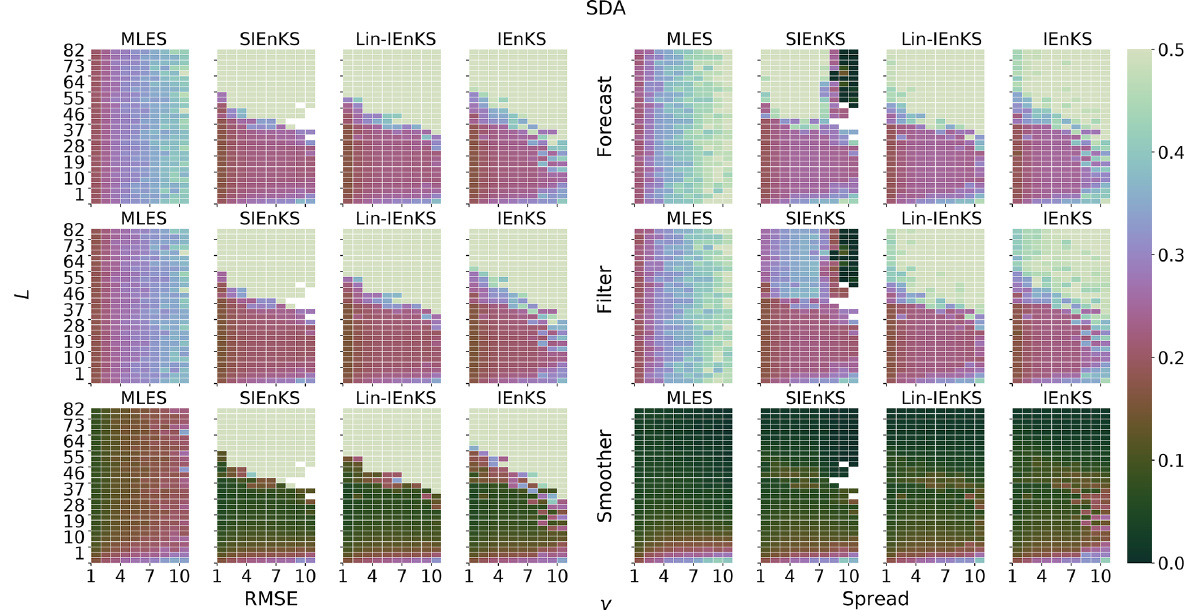
Figure 15. Lag length L on the vertical axis and nonlinearity parameter γ on the horizontal axis. SDA, tuned inflation, shift S = 1, N e = 21, and (cid:49)t = 0 . 05 are indicated.